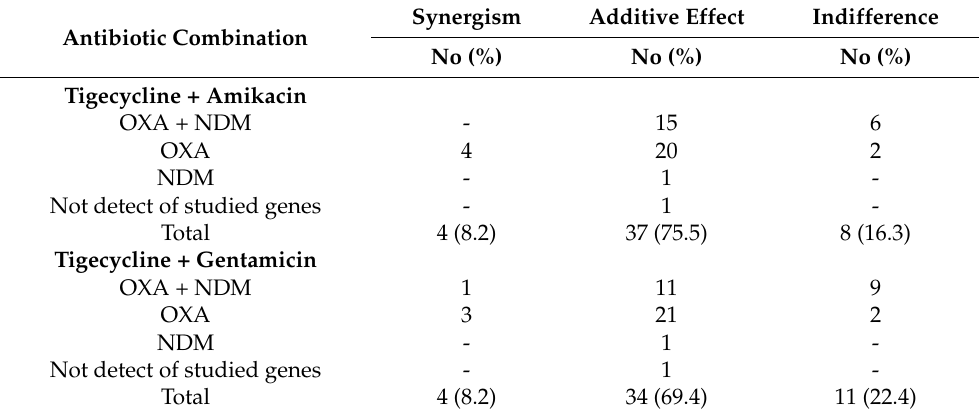
Table 3. In vitro checkerboard synergistic testing against 49 CRKP isolates ( n = 49) based on car- bapenemase genes.